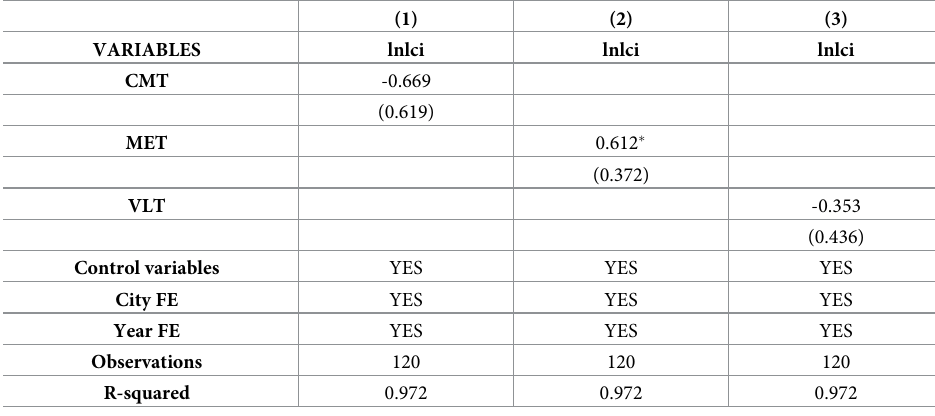
Table 6. The impact of policy tools on the transformation of low carbon